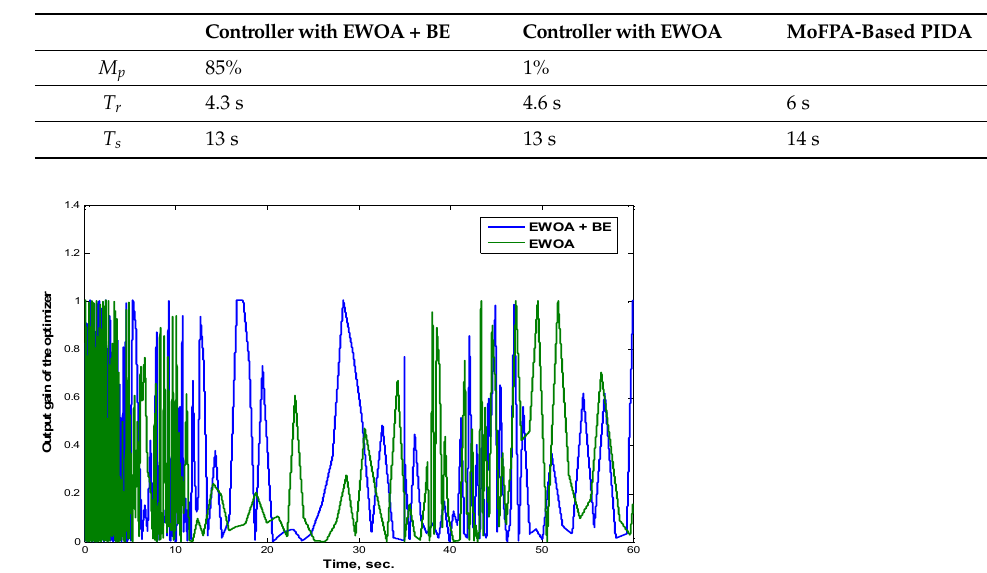
Figure 7. System dynamic performance of the second scenario. Table 2. Performance specification due to second case.